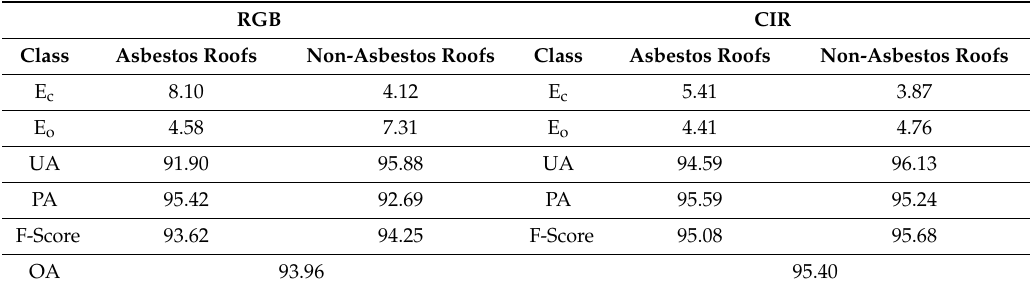
Table 2. Accuracy measures for spatial distribution map of the result of the classification of roofing materials in the Ch˛eciny commune